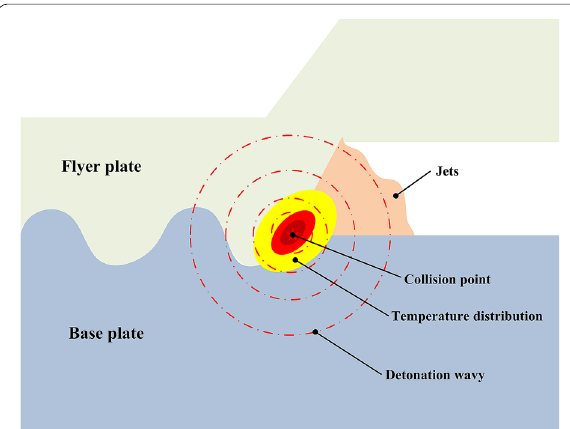
Figure 7 Simplified schematic of the temperature distribution at the collision zone during explosive